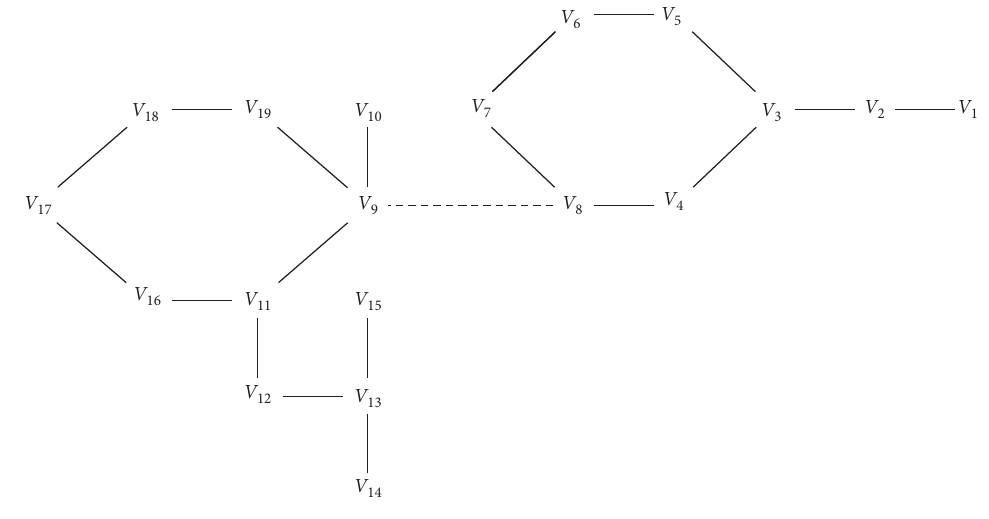
Scheme 2: The graph of